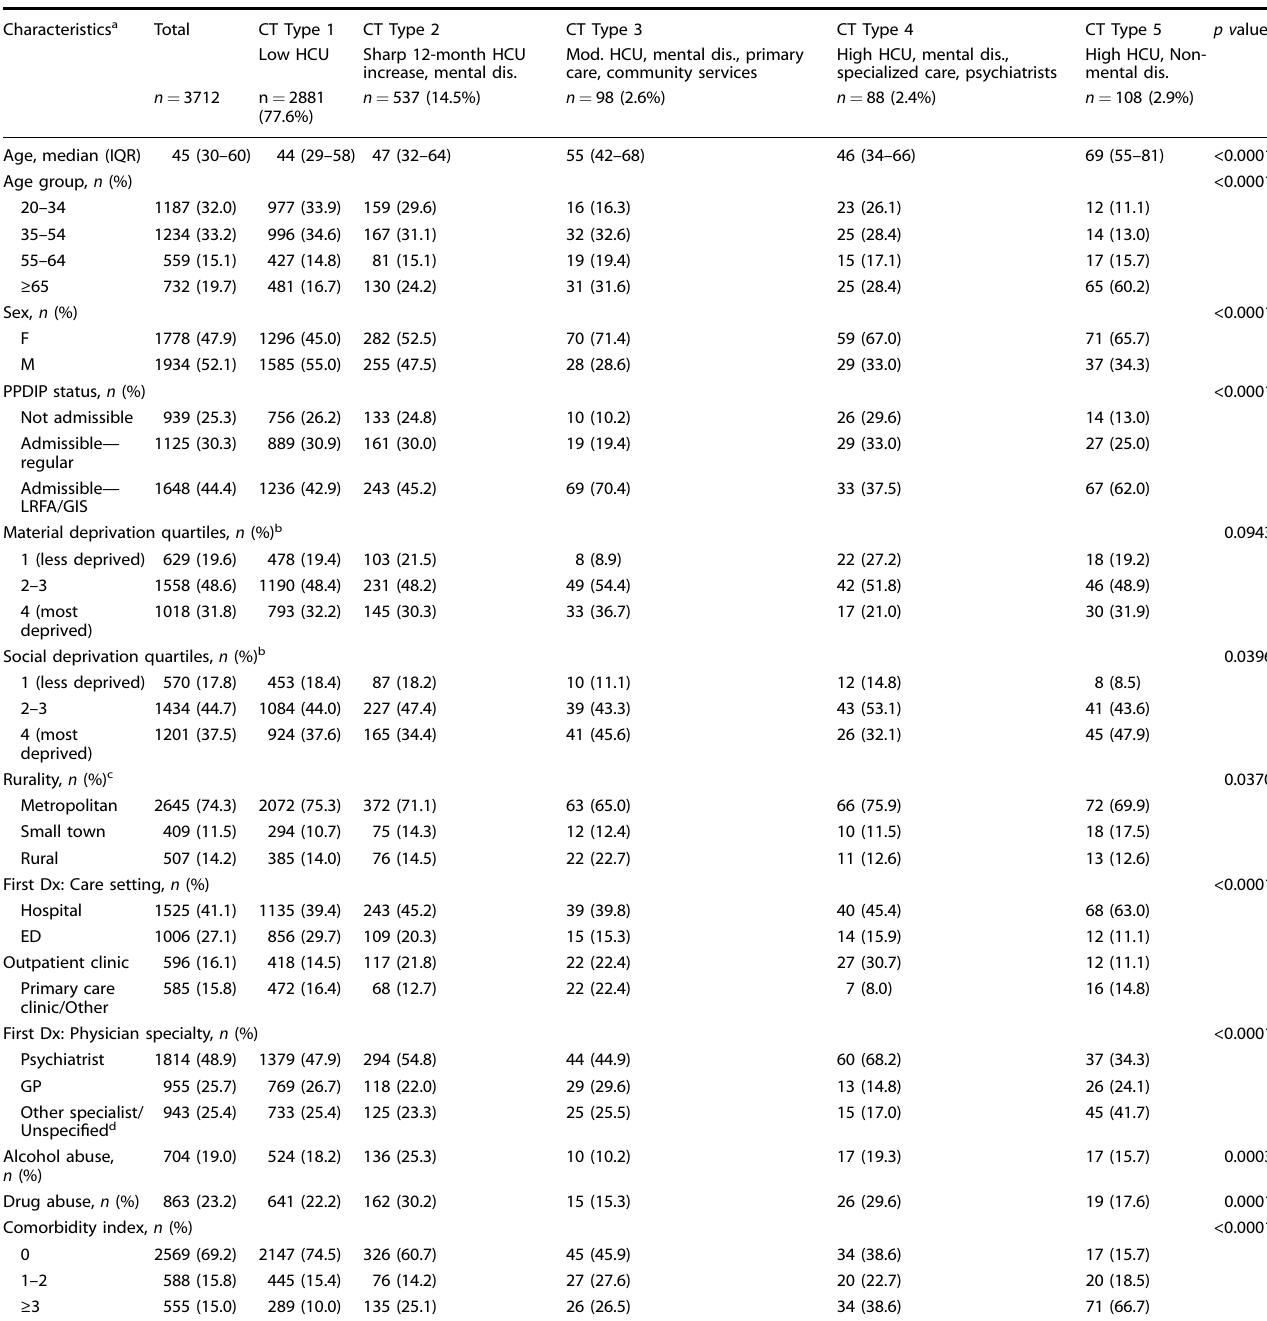
Table 2. Characteristics of the study cohort by the typology of care trajectories (CTs) ( n =